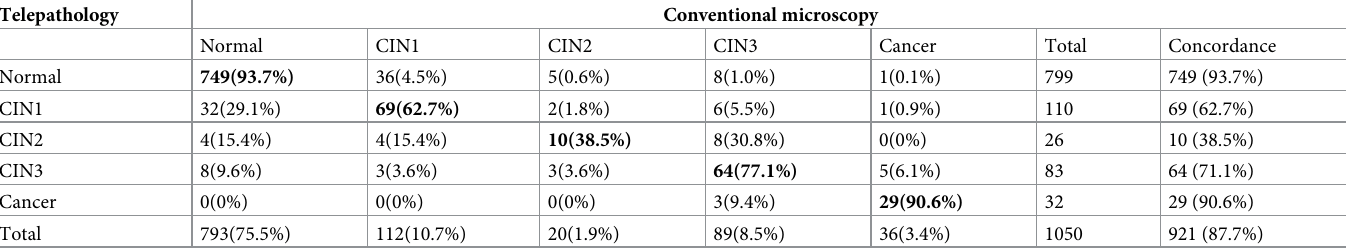
Table 3. Agreement of diagnoses established on conventional microscopy compared to telepathology across three pathologists. Telepathology